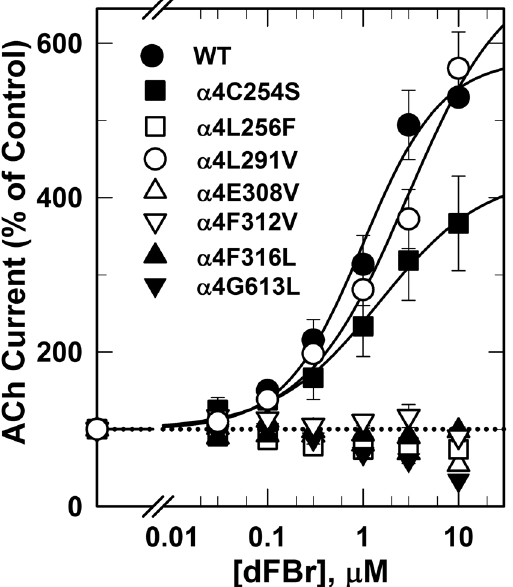
Figure 8. dFBr concentration-dependent potentiation of WT and mutant α 4 β 2 nAChRs. Peak current of Xenopus oocytes expressing WT or mutant ( α 4)3( β 2)2 nAChRs responses to 10 s application of 10 μ M ACh in the absence or presence of increasing concentrations of dFBr were normalized to the peak current elicited by 10 µ M ACh alone. Shown are data (Average ± SE) from at least 4 different oocytes. Data were fit to a single site model using Equation 1. Values of dFBr potentiation EC 50 / I max /h were: for WT ( α 4)3( β 2)2, 1.0 ± 0.3 μ M/580 ± 42%/1.1 ± 0.2; for ( α 4C254S)3( β 2)2, 1.5 ± 0.5 μ M/430 ± 31%/0.8 ± 0.1; and for ( α 4L291V)3( β 2)2, 2.9 ± 1.9 μ M/600 ± 136%/0.8 ± 0.2. For ( α 4L256F)3( β 2)2, ( α 4E308V)3( β 2)2, and ( α 4G613L)3( β 2)2, inhibition at 10 μ M dFBr were ~25, 45, and 65%,